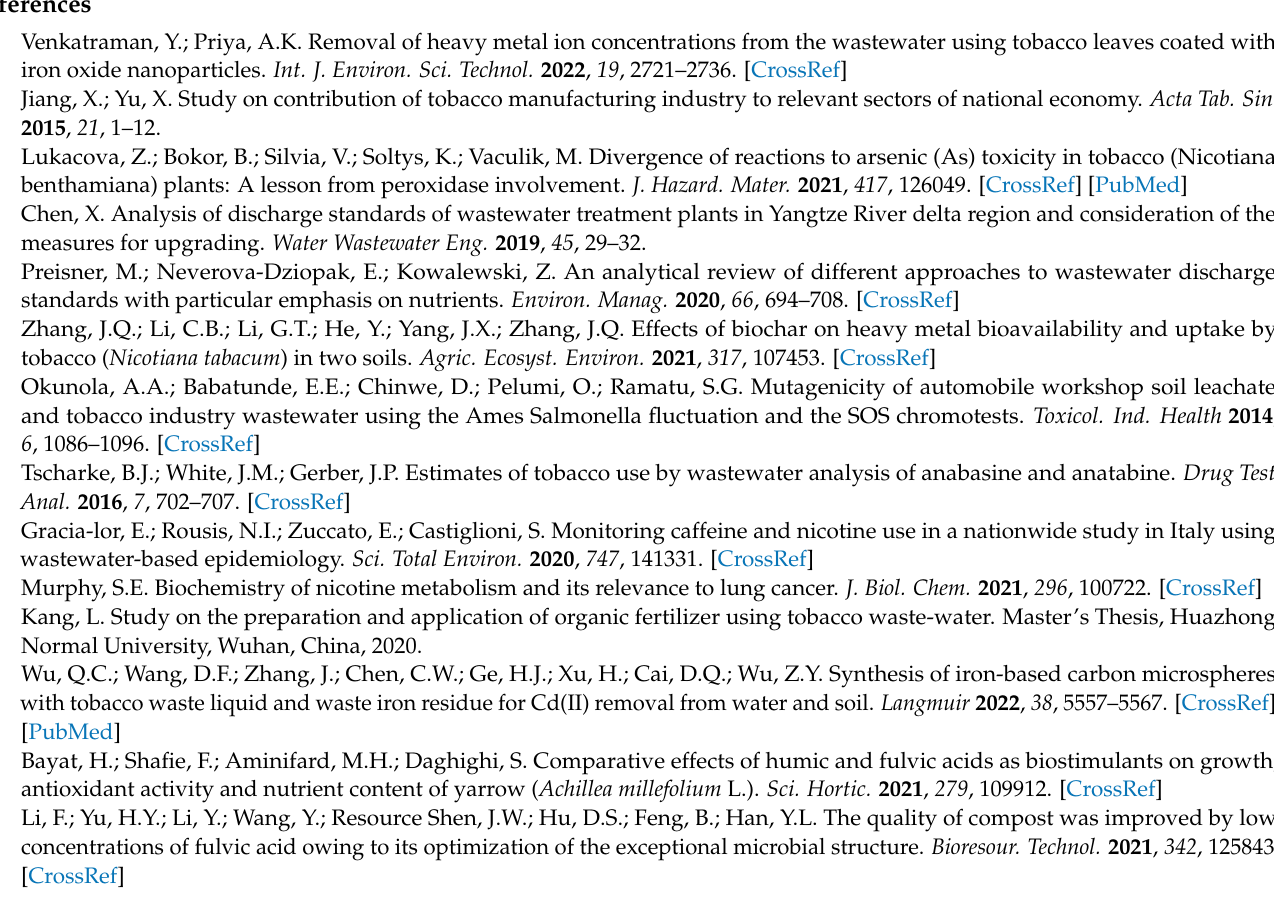
Table S1: The composition analysis of tobacco waste